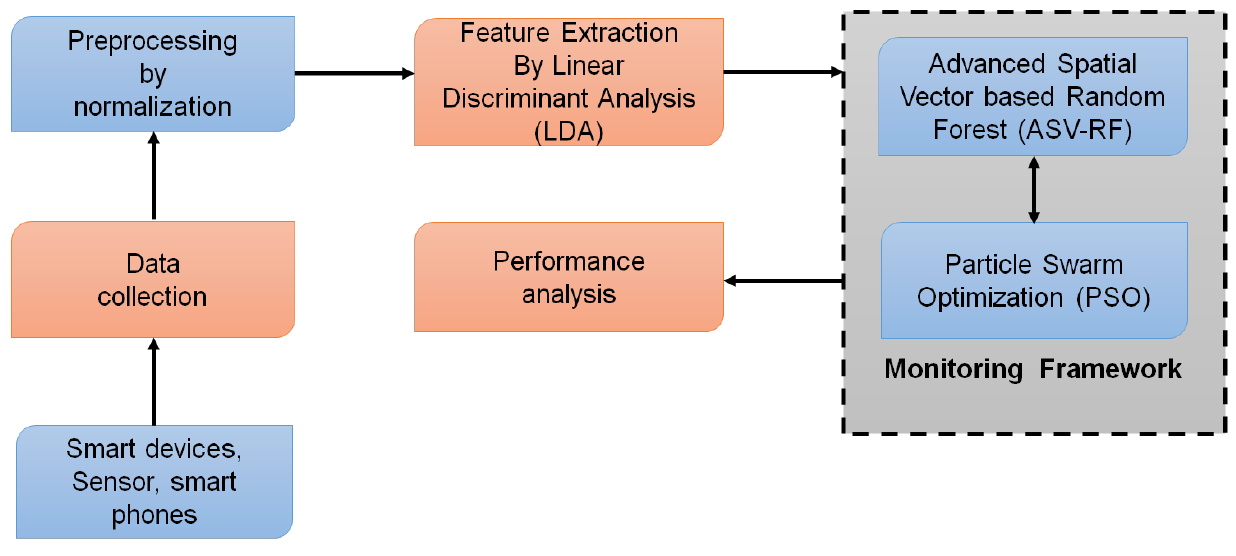
Figure 1. Proposed framework.